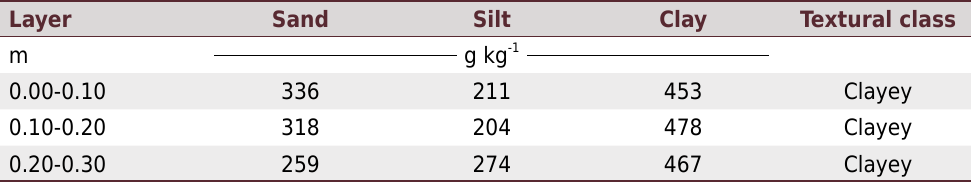
Table 1. Soil particle size in the 0.00-0.10, 0.10-0.20, and 0.20-0.30 m soil layers after 58 months of revegetation Layer Sand Silt Clay Textural class m g kg -1 0.00-0.10 336 211 453 Clayey 0.10-0.20 318 204 478 Clayey 0.20-0.30 259 274 467 Clayey Sand, silt, and clay: pipette